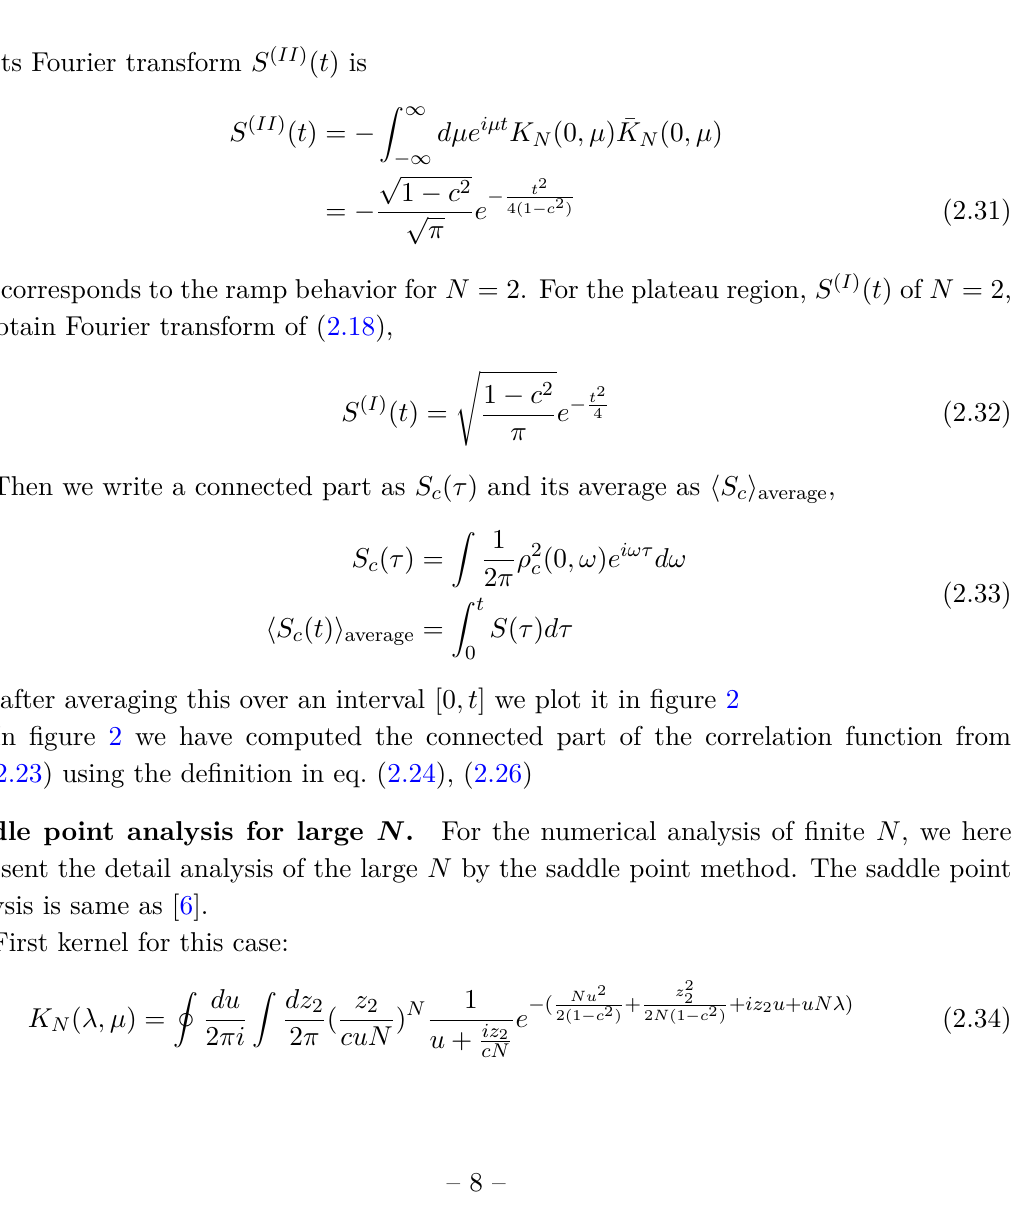
Figure 2 . Spectral Form Factor average S c = ( S I + S II ) Hermite + S d where the connected part is evaluated using the hermite polynomial representation of the